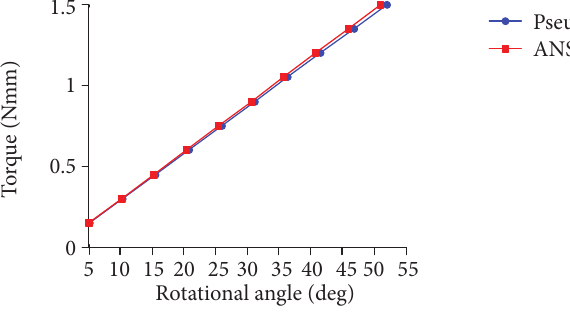
Figure 9. Comparison of simulation and theoretical results.